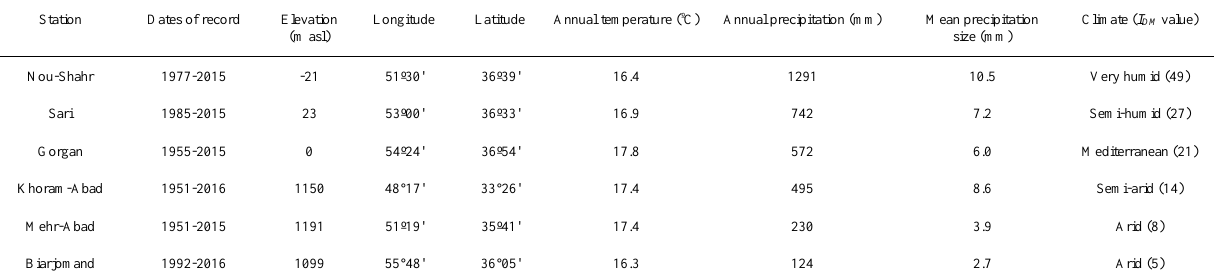
Table 2. Details of weather stations included in this study, their climate types according to the de Martonne aridity index ( I DM : Baltas, 2007), and the duration of their measurement